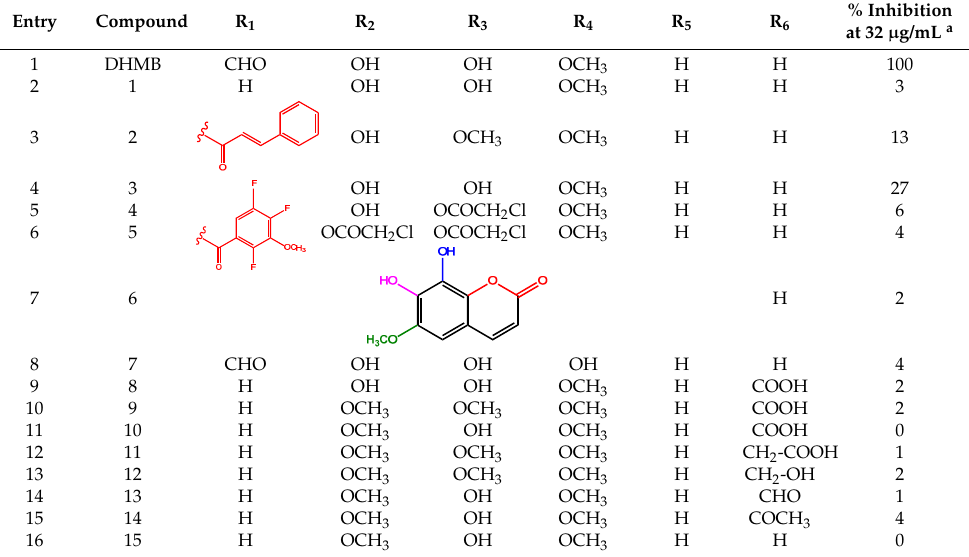
Figure 1. Chemical structure of DHMB and related investigated compounds. Table 1. Chemical modifications of DHMB and their impact on activity.